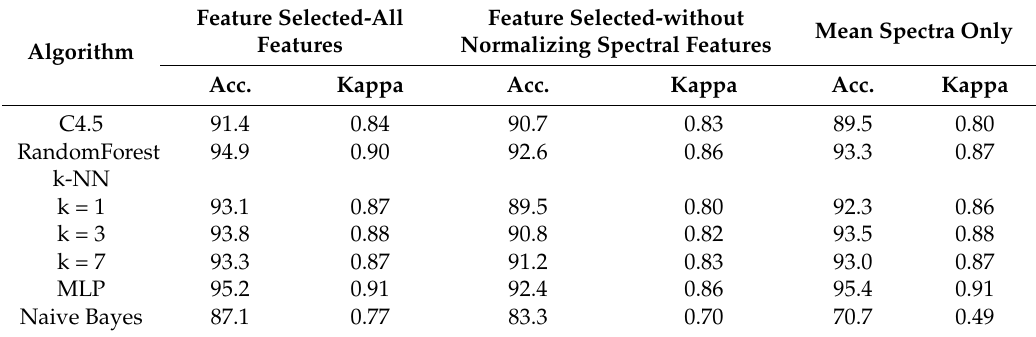
Table 11. Classification accuracies and Kappa values of tested classification methods using feature-selected datasets and mean spectra